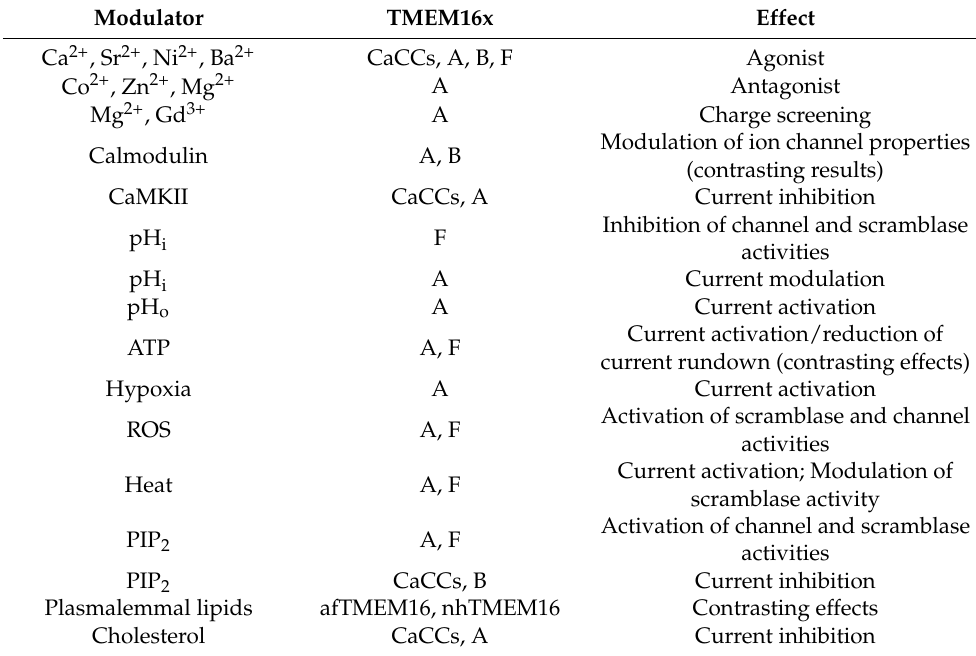
Figure 4. Summary of the principal factors that control TMEM16x function. Schematic representation of various physiological modulators of TMEM16x activity. A TMEM16x protein in the plasma membrane of a generic cell is shown in blue. Factors that control TMEM16x activity are connected to the protein with red or blue lines to denote inhibitory or stimulatory influences, respectively. The black dashed arrows indicate the modulations for which an underlying mechanism has not yet been fully defined and/or conflicting evidence has been proposed. Table 1. List of the key factors controlling TMEM16x